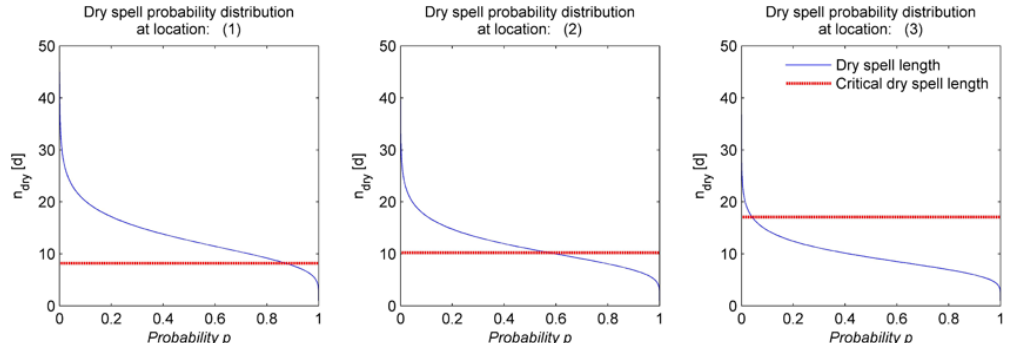
Fig. 5. Cumulative dry spell distribution for the three locations indicated in Fig. 4. This can be obtained from Eq. (10) calculating for each probability of non-exceedance ( p ne ) its n dry , max .